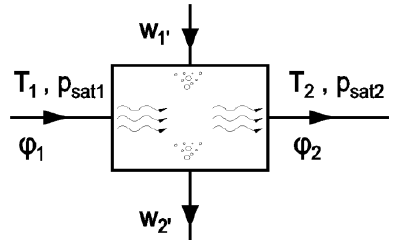
Figure 7. Moisture balance in the dryer compartment.